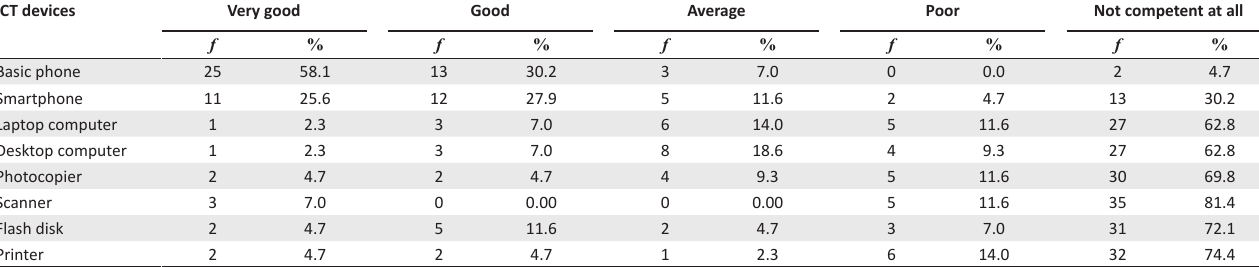
TABLE 1: Competence of health surveillance assistants in using information and communication technology devices ( n = 43). ICT devices